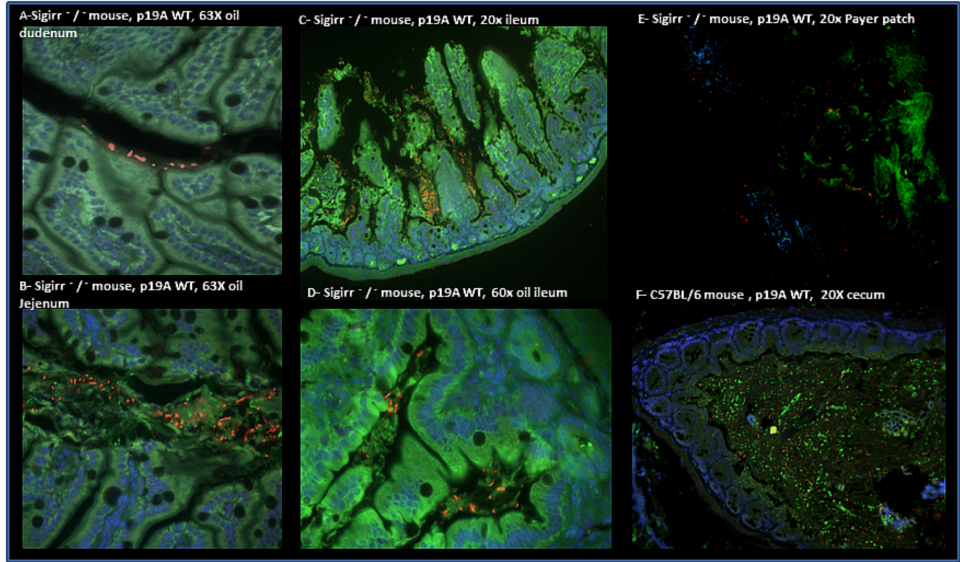
Figure 5. Immunofluorescence staining of the experimental mouse intestinal tissues. ( A ) p19A WT (in red) is shown in the duodenum of a p19A WT infected Sigirr − / − mouse. ( B ) p19A WT (in red) is shown in the jejunum of an infected Sigirr − / − mouse. ( C ) p19A WT (in red) is shown in the ileum of an infected Sigirr − / − mouse. ( D ) p19A WT (in red) is attached to epithelial cells along the ileal crypt / villus in an infected Sigirr − / − mouse. ( E ) Immunofluorescence staining of the Peyer patches of a p19A WT infected Sigirr − / − mouse, showing p19A WT in red attached to the Payer’s patches. ( F ) p19A WT in red, shown in the cecum of an infected C57BL / 6